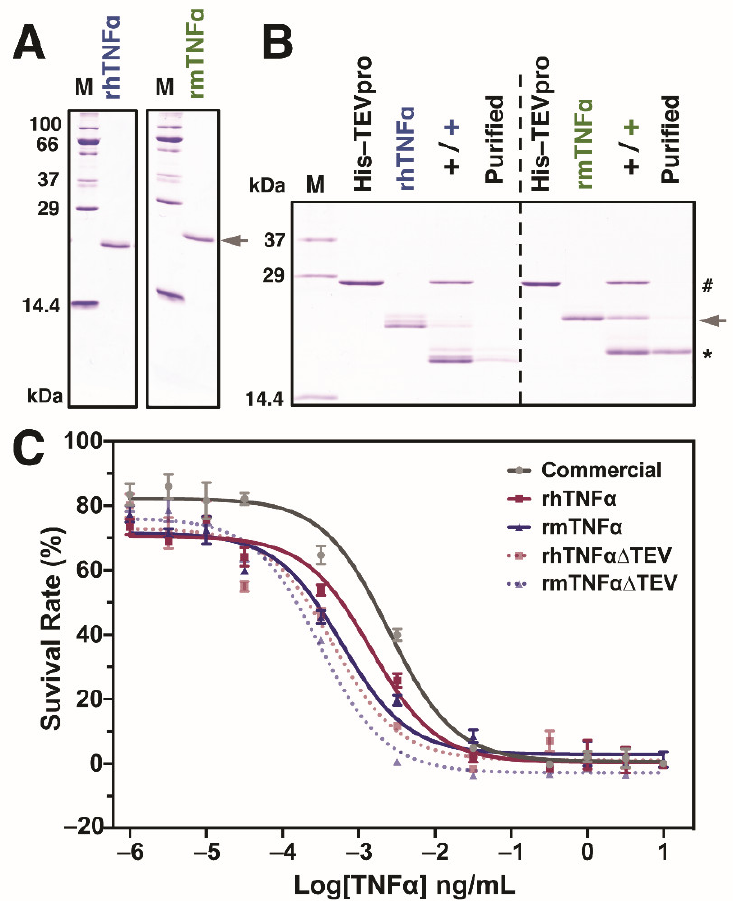
Figure 3. Biological activity of purified TNF α proteins using the cell viability assay in mouse fibroblast cells L929. The purified hTNF α and mTNF α proteins were shown with a decent purity in ( A ). To investigate whether or not the additional affinity tags negatively impact the protein activity, both proteins were digested with TEV proteinase for activity verification ( B ). After incubation, the resulting products were further purified via binding to His-beads for removing TEV protease and undigested TNF α contaminations. # indicates His-tagged TEV proteinase (His-TEVpro); the arrowhead indicates hTNF α and mTNF α with affinity tags; * indicates fully digested TNF α without C-terminal affinity tags. ( C ) Cell Counting Kit-8 (CCK8) assay was performed to investigate and compare commercial E. coli -derived TNF α (murine type, grey line) with silkworm-derived TNF α proteins with (hTNF α and mTNF α , red and blue line) or without affinity tags (hTNF α ∆ TEV and mTNF α ∆ TEV, red and blue dotted line). All data were represented by the mean ± standard error of four independent values.